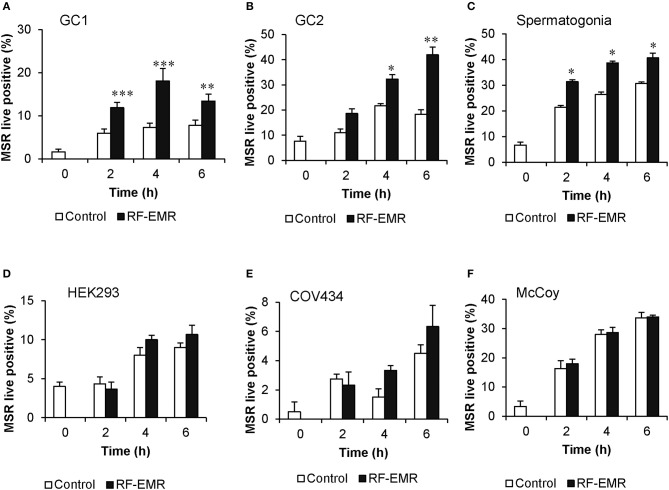
RF-EMR exposure (1.8 GHz, 0.15 W/kg) induces mitochondrial superoxide generation in male germ cells. (A) Spermatogonia-like (GC1) cell line, (B) spermatocyte-like (GC2) cell line, and (C) spermatogonia isolated from neonatal mice were seeded to glass coverslips overnight and exposed to RF-EMR (1.8 GHz, 0.15 W/kg) for periods of up to 6 h. Somatic cell lines comprising (D) human embryonic kidney cells (HEK293), (E) granulosa cells (COV434) and (F) mouse fibroblasts (McCoy), were treated under an identical exposure regime (1.8 GHz, 0.15 W/kg) as negative controls. At regular intervals during exposure, a portion of the cells were assessed for mitochondrial ROS production using the MitoSOX red (MSR) probe. This analysis was restricted to the live cell population as determined by co-labeling with SYTOX green vitality stain. These analyses were performed on at least three biological replicates and data are presented as mean ± SEM. ***p < 0.001, **p < 0.01, *p < 0.05 compared to unexposed controls.